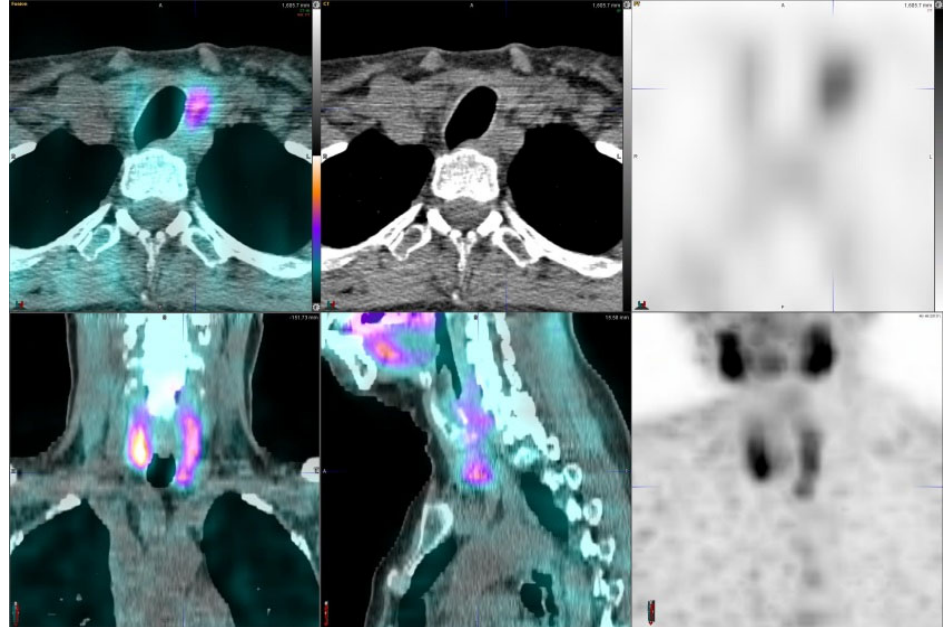
Figure 5. A 65-year old female with hyperparathyroidism. A left inferior parathyroid adenoma, weighing 123 mg and an intrathyroid nodule on the right are seen. Her S-PTH concentration was 154 ng/L and S-Ca 10.9 µ g/L. The SUVmax values of the left-sided adenoma were 5.1 (CGZAS) and 3.1 (CGAS), respectively. Visually, this uptake was weak (1 < TBR < 2) and lesion diameter on CT was 7 mm. The intrathyroid nodule demonstrated higher uptake. This is a potential pitfall in adenoma imaging, but can be avoided by multimodality practice.